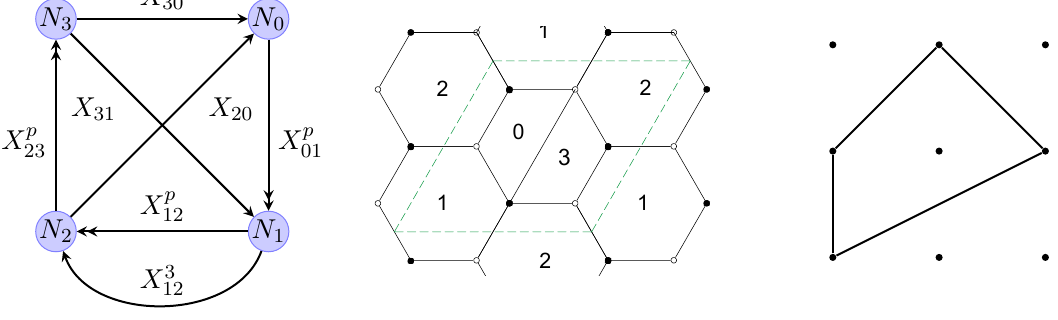
Figure 10. The quiver (left), the dimer (center) and the toric diagram (right) of dP 1 .